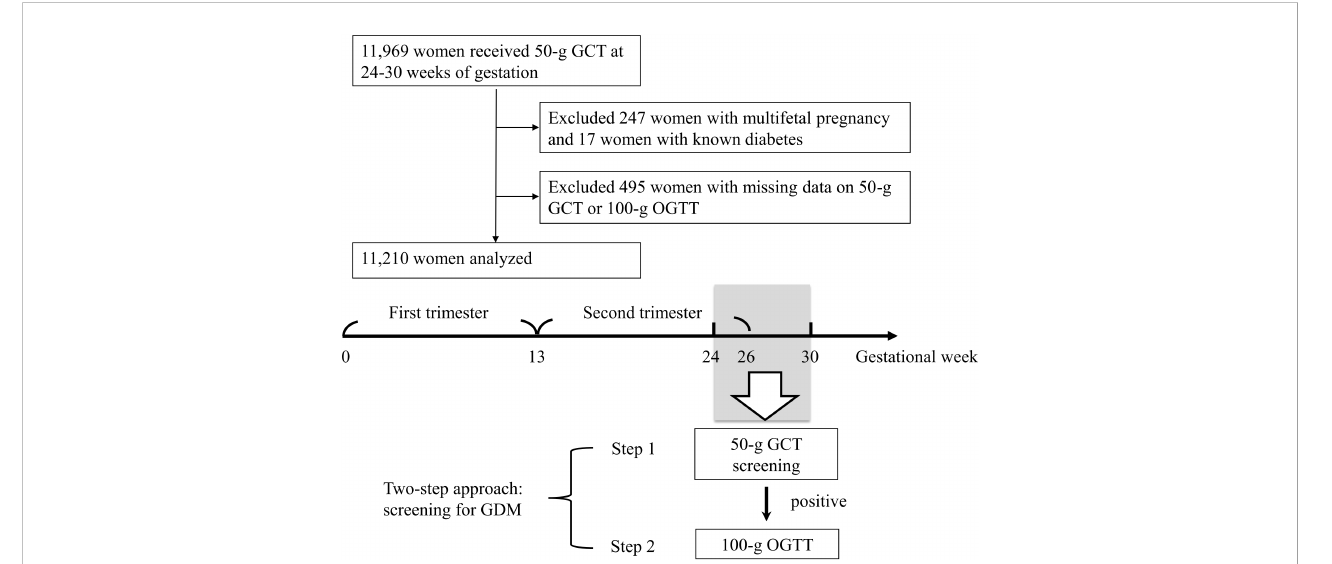
FIGURE 1 Enrollment of the study population. GCT, glucose challenge test. GDM, gestational diabetes mellitus. OGTT, oral glucose tolerance